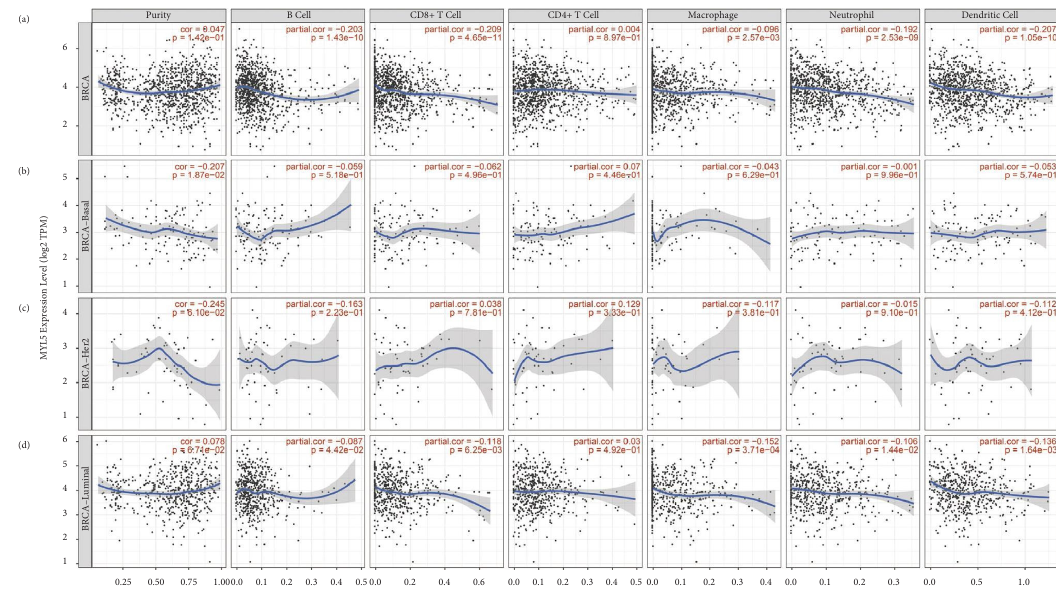
Figure 5: Association between MYL5 expression and immune infltrate cells in diferent molecular subtypes of BRCA. We used the TIMER tool to analyze the correlation of MYL5 expression with B cell, M1 macrophage, M2 macrophage, tumor-associated macrophage (TAM), monocytes, and T cell exhaustion among BRCA (a), BRCA-Basal (b), BRCA-Her2 (c), and BRCA-luminal (d).